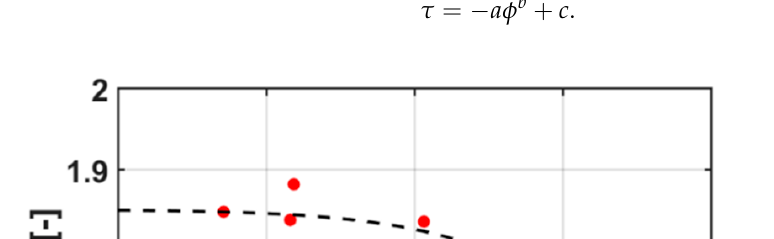
tion of simulation data according to Equation (10). of simulation data according to Equation